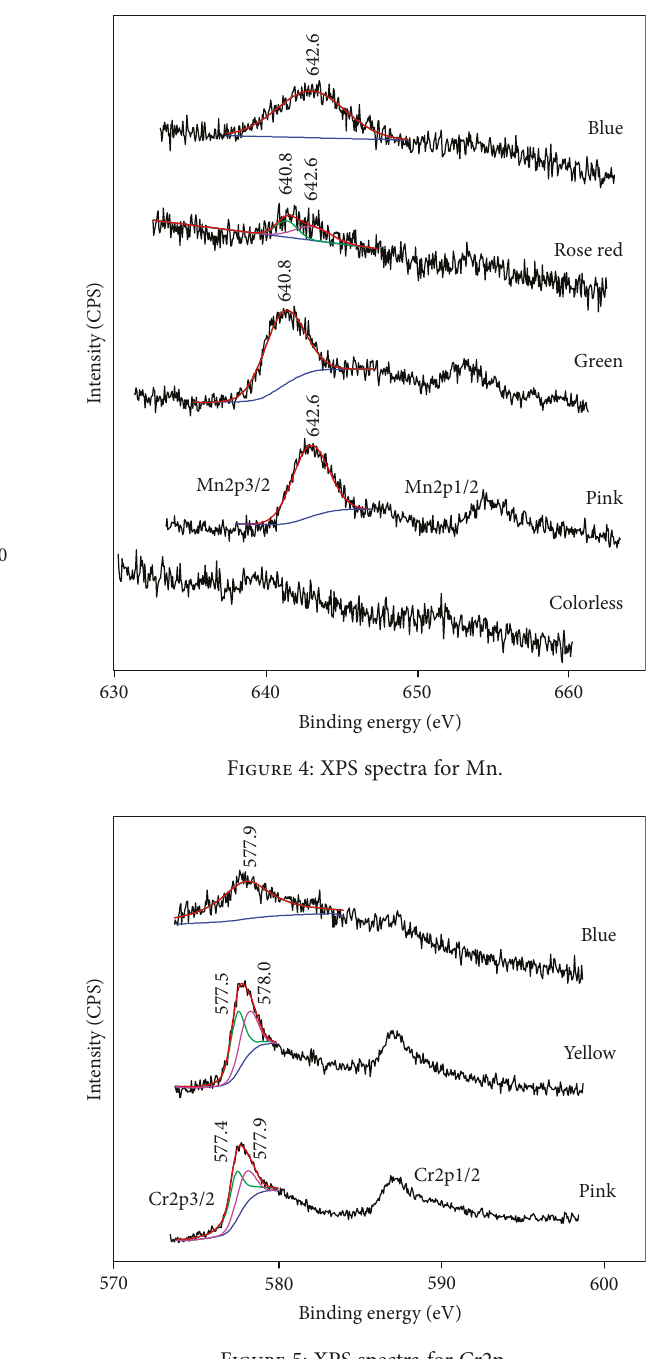
Figure 5: XPS spectra for